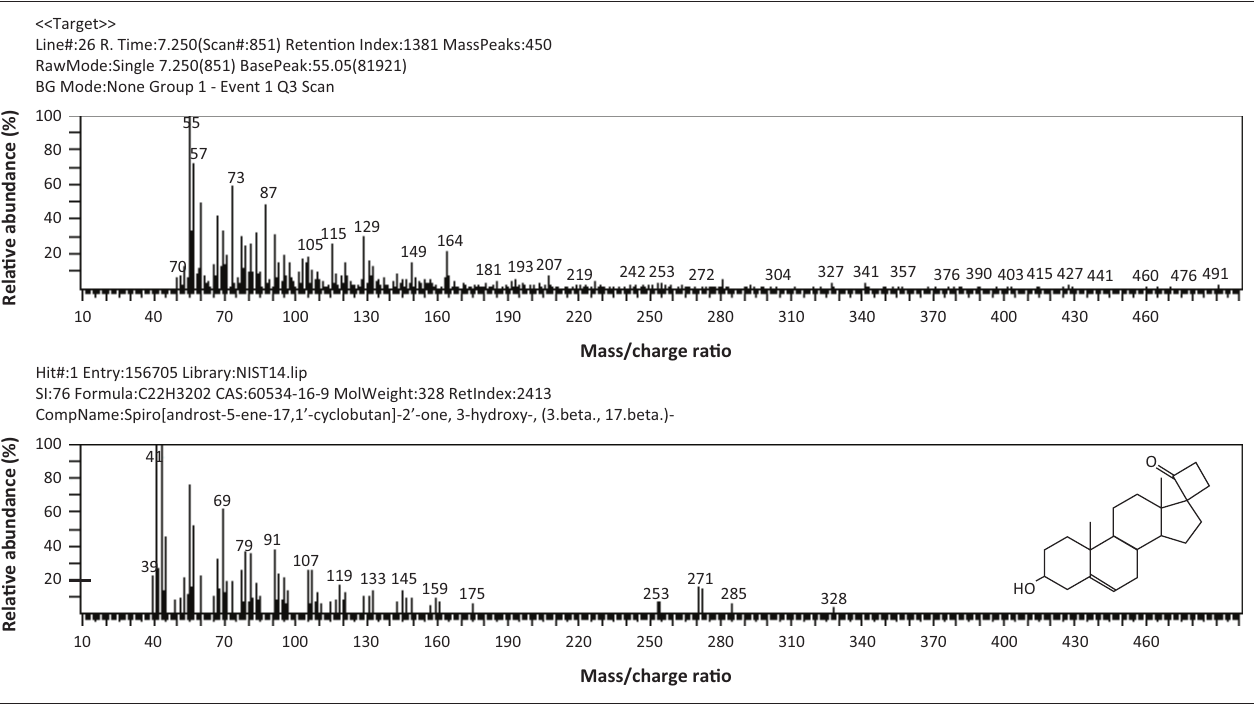
FIGURE 4: Gas chromatography–mass spectrometry spectra of spiro[androst-5-ene-17,1-cyclobutan]-2-one, (3-hydroxyl-, 3,beta,17.beta)- as identified with the help of an National Institute of Standards and Technology spectral